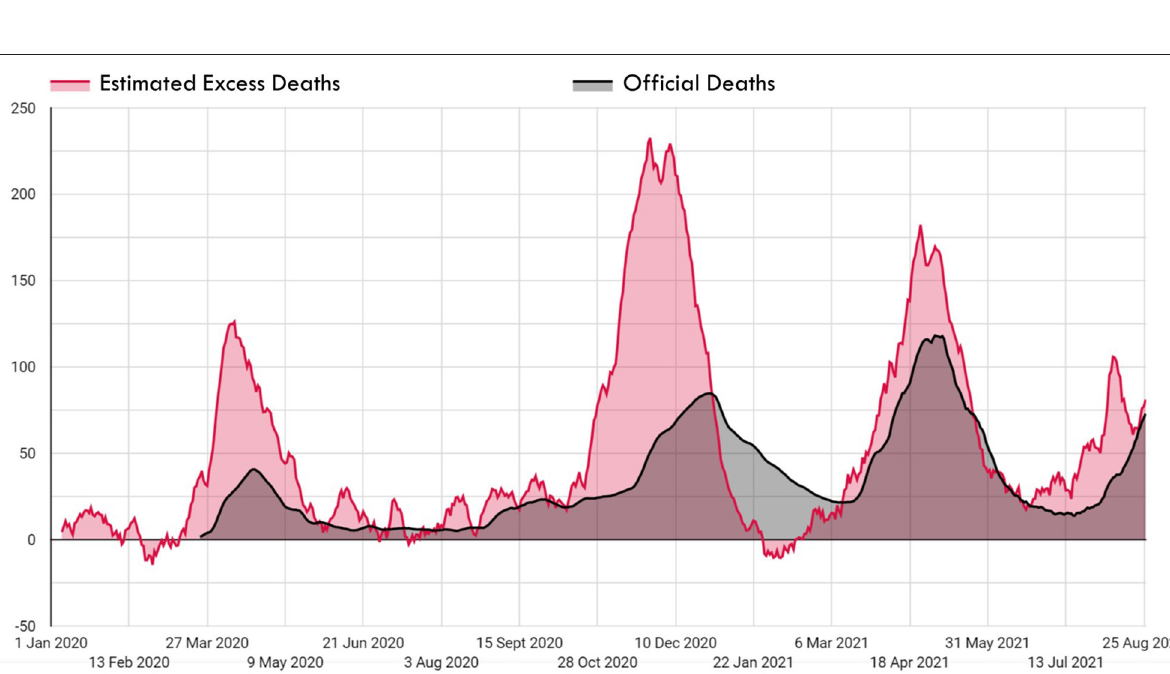
deaths that occurred in hospitals do not represent all COVID- 19 deaths (6). In this context, the Statistics Netherlands’s